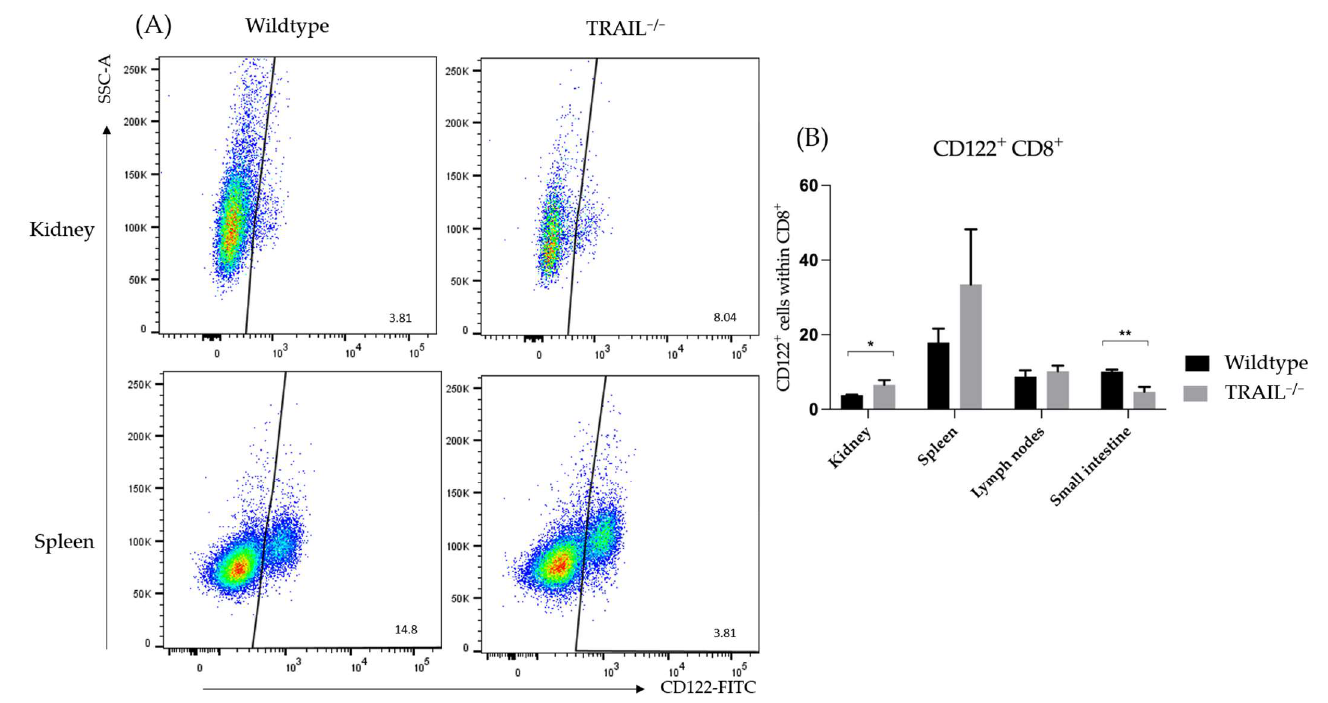
Figure 8. Histogram compares means ± SEM of Tregs in kidney, spleen, lymph nodes, and small intestines of TRAIL −/− mice versus wildtype C57BL/6 mice ( t -test, n = 6 per group).